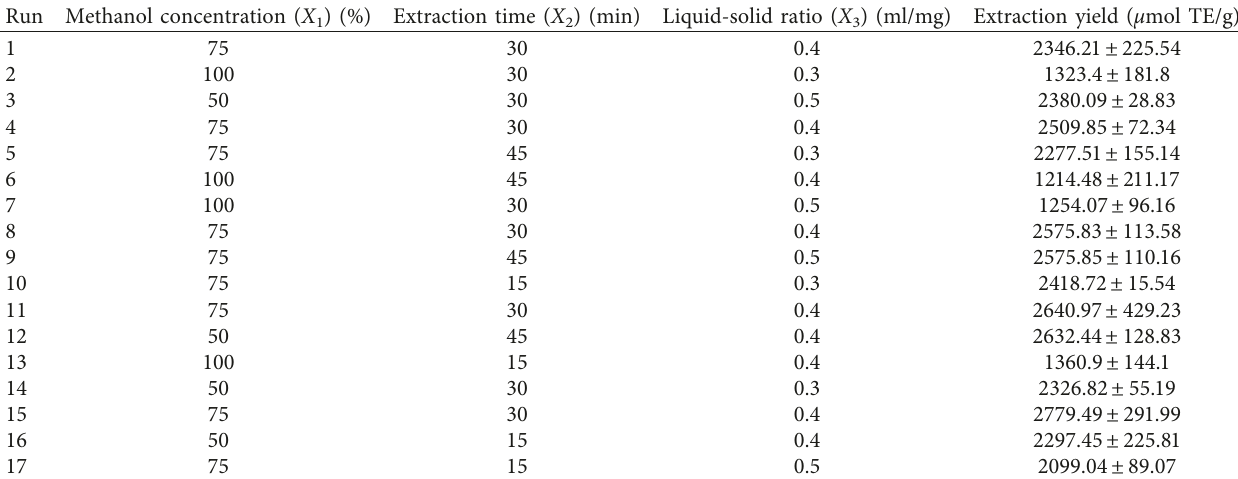
Table 3: Box–Behnken design and result of response surface method analysis.